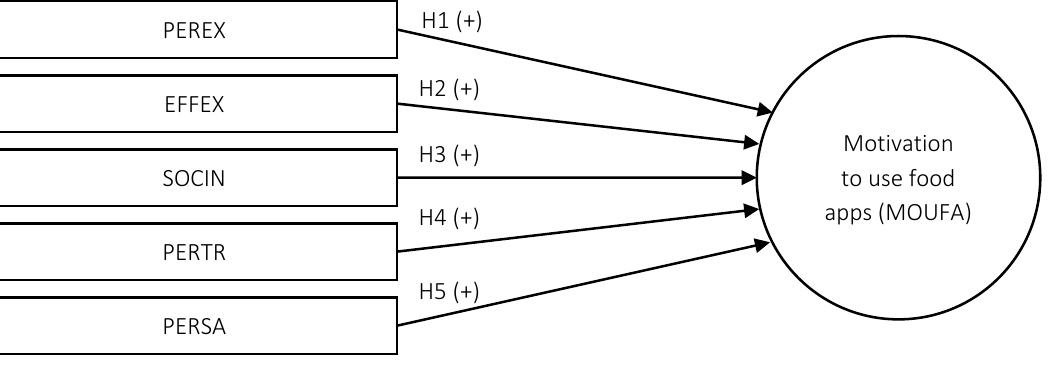
Figure 1. Theoretical